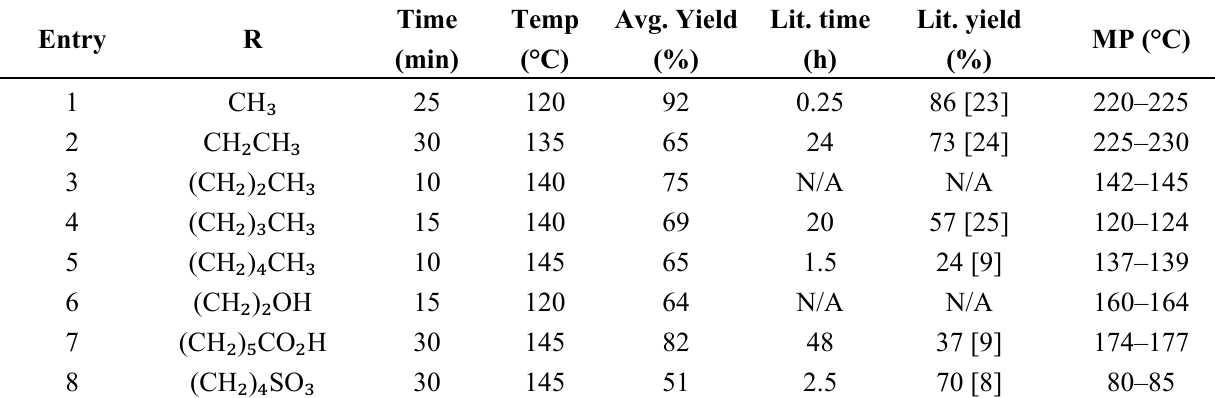
Table 1. Synthesis of trimethylbenz[e]indolium deriviatives (Biotage Initiator